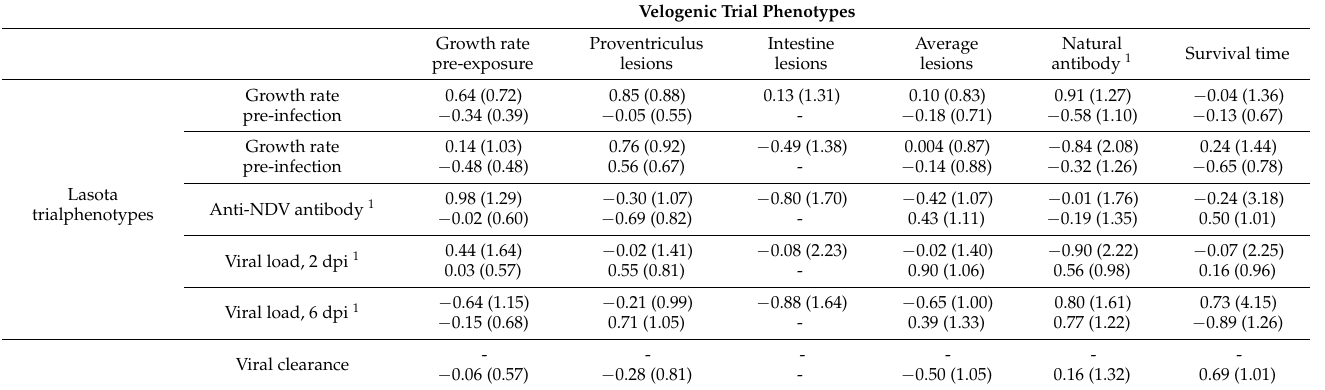
Table 4. Estimates of genetic correlations between traits measured in the Lasota and velogenic trials for Tanzania (top row) and Ghana (second